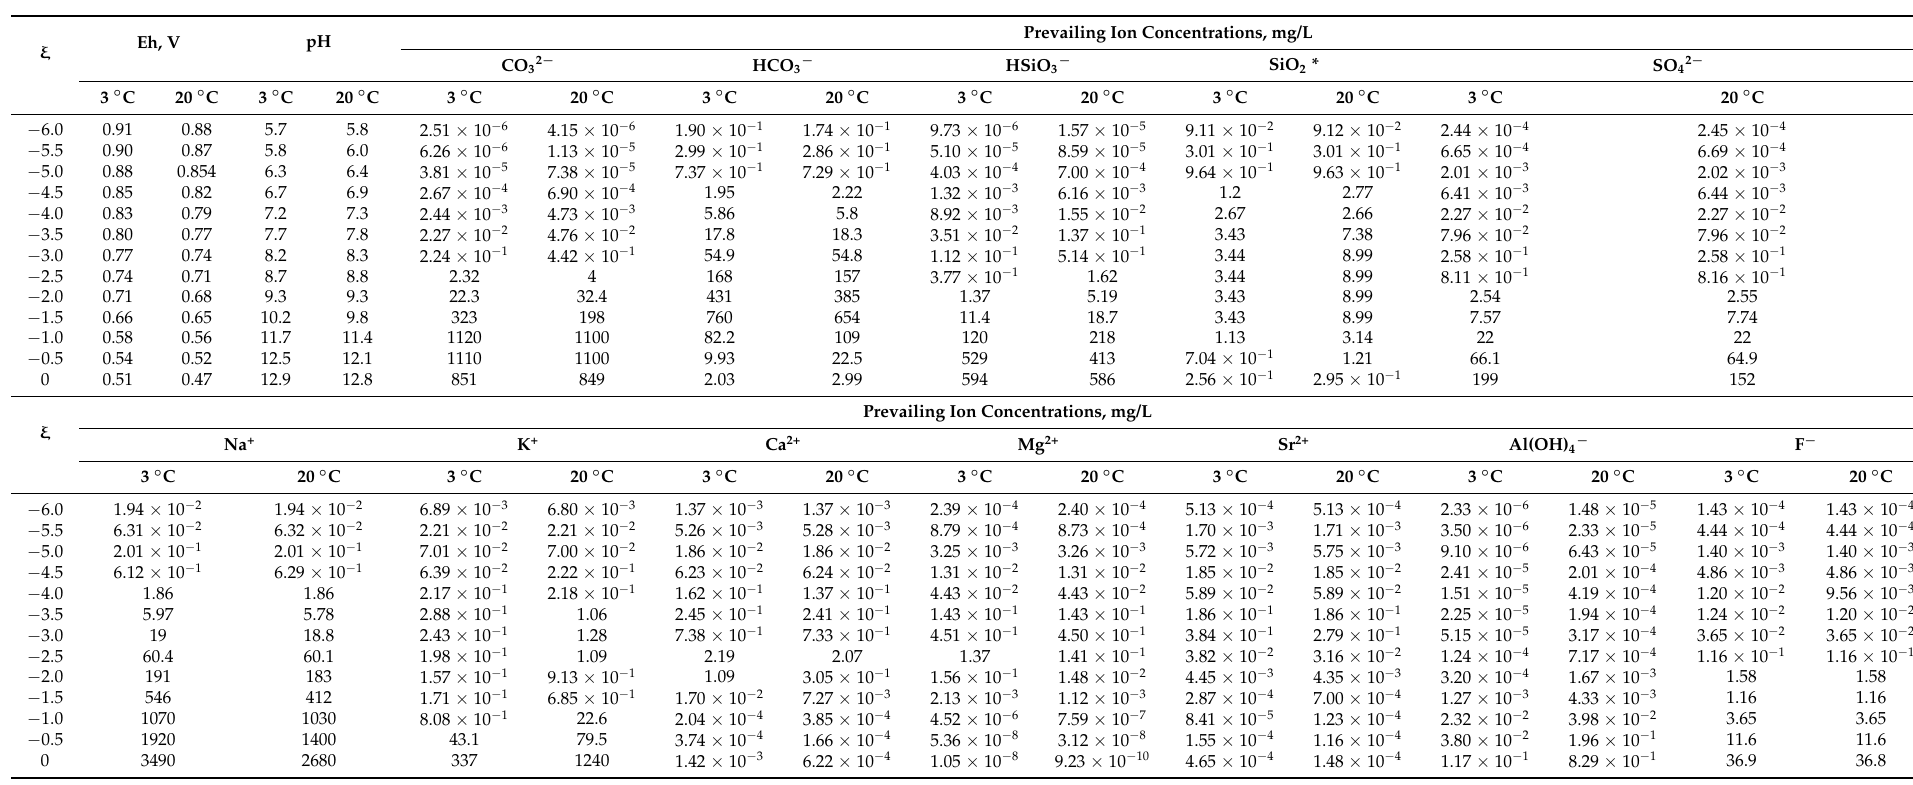
Table 3. Change in Eh, pH and concentrations of prevailing ions depending on the degree of interaction at temperatures of 3 ◦ C and 20 ◦